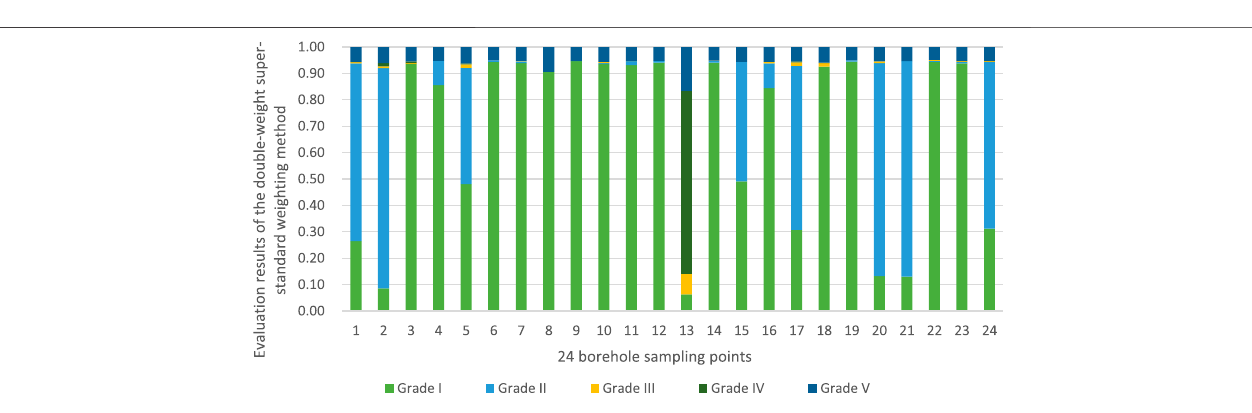
FIGURE 9 | The evaluation results of the double-weight super-standard weighting method.